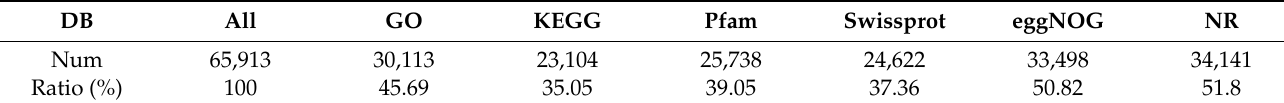
Table 3. Summary of function annotation of taproot in garden ginseng.